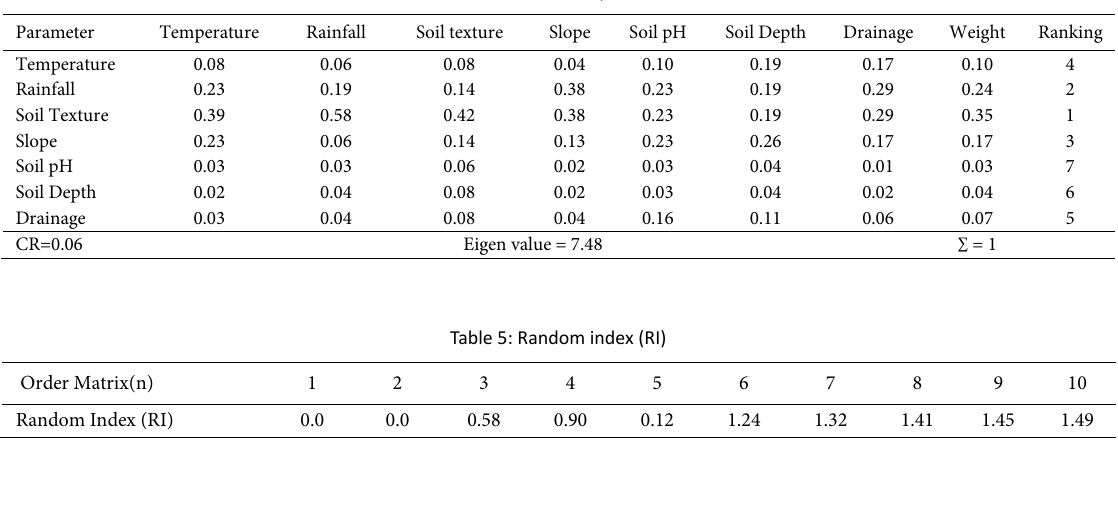
Table 4: Normalized comparison matrix